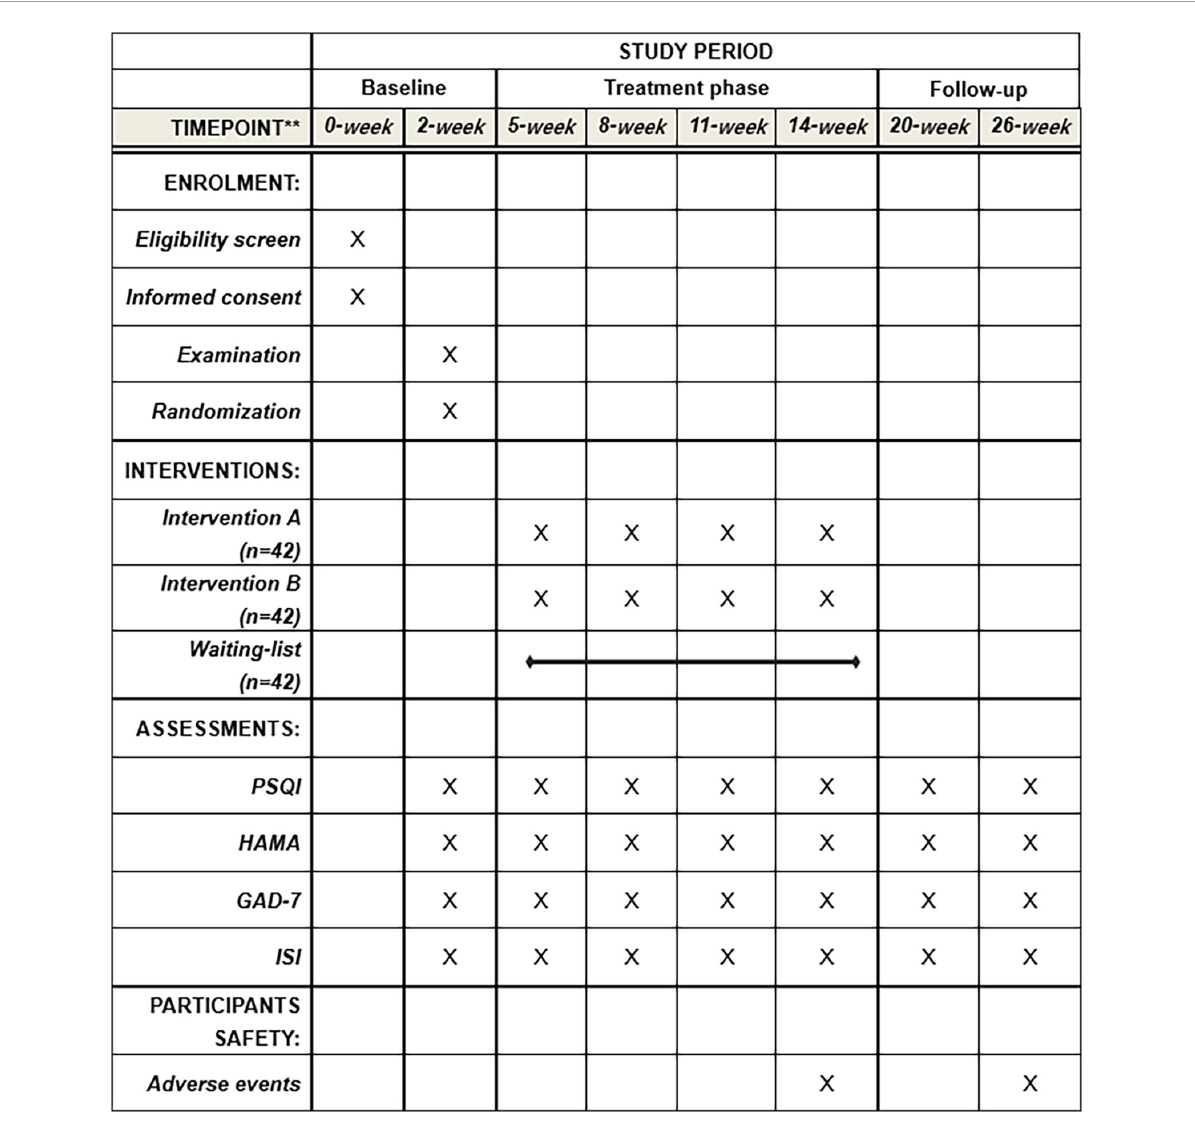
FIGURE2 Standard protocol items. PSQI, Pittsburgh sleep quality index; HAMA, Hamilton Anxiety Scale; GAD-7, Generalized Anxiety Disorder; ISI, Insomnia Severity